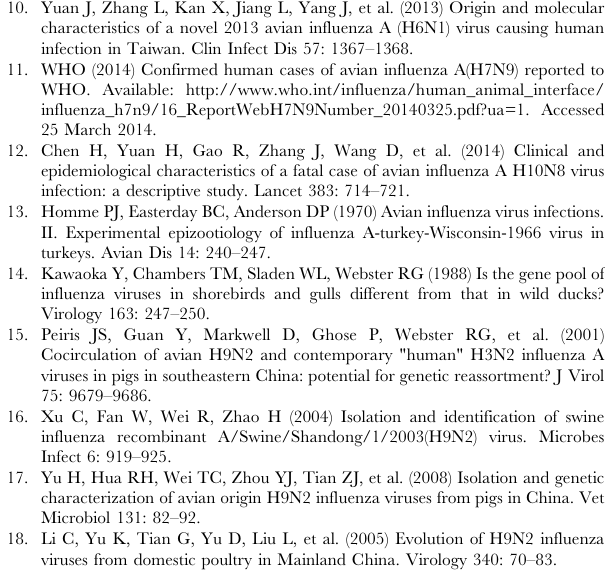
Table S1 Mutations detected in the H9N2 viruses that contribute to the increased binding to human-type receptors, transmission, replication, and virulence in mammals, as well as to resistance to amantadine and rimantadine. Table S2 Virus binding affinity to sialylglycopolymers. Table S3 Virus selection scenarios for the ferret study. Table S4 The body temperature increase and body weight loss of each of the ferrets inoculated with or exposed to the different H9N2 influenza viruses. Table S5 Assessment of the presence of the 627K and 701N mutations in the PB2 segment of stock viruses and viruses recovered from the nasal washes of H9N2 influenza virus-infected or -exposed ferrets by use of deep